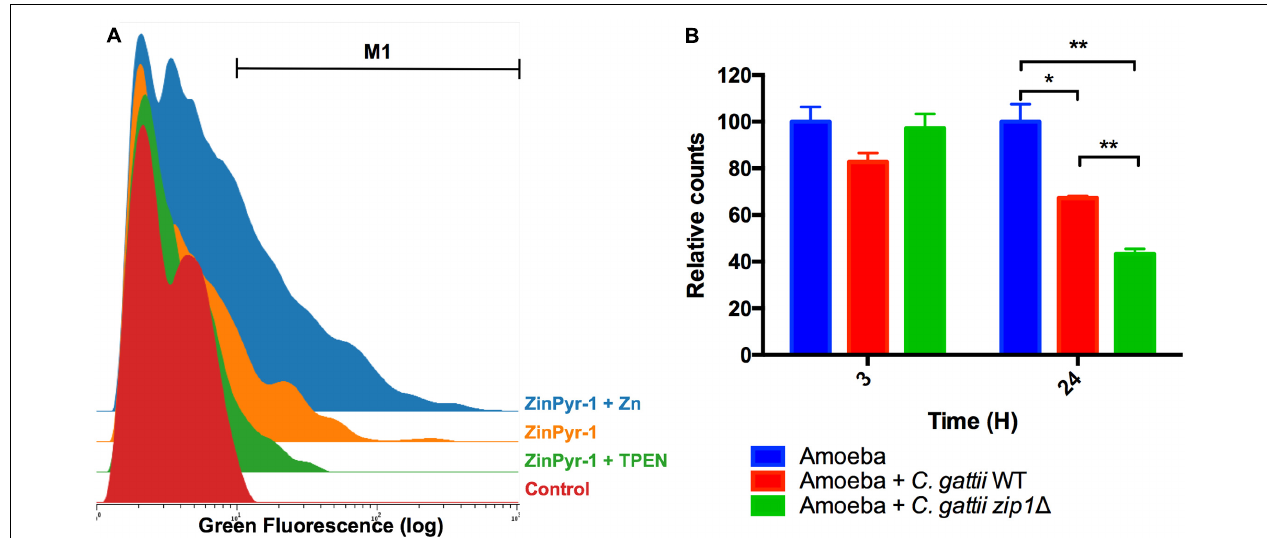
FIGURE 2 | Acanthamoeba castellanii cells reduce intracellular zinc levels in the presence of C. gattii . (A) Cytometry histogram of ZinPyr-1 fluorescence A. castellanii cells cultured in PYG (Control), PYG plus 10 µ M zinc chelator TPEN (TPEN) and PYG plus 50 µ M ZnCl 2 . (B) A. castellanii (1 × 10 5 cells) and C. gattii WT or zip1 (cid:49) (1 × 10 6 cells) were incubated at 1:10 ratio in PYG medium for 3 and 24 h at 30 ◦ C. The wells were washed with PBS and then incubated with Zinpyr-1 cell-permeable fluorescent probe for 30 min. After, washes with PBS were performed and the cells were collected for flow cytometry analysis. Data are shown as the mean ± SD from three experimental replicates per condition. The asterisks denote statistically significant differences between the conditions, as evaluated by Student’s t -test ( ∗ p < 0.05; ∗∗ p < 0.01).